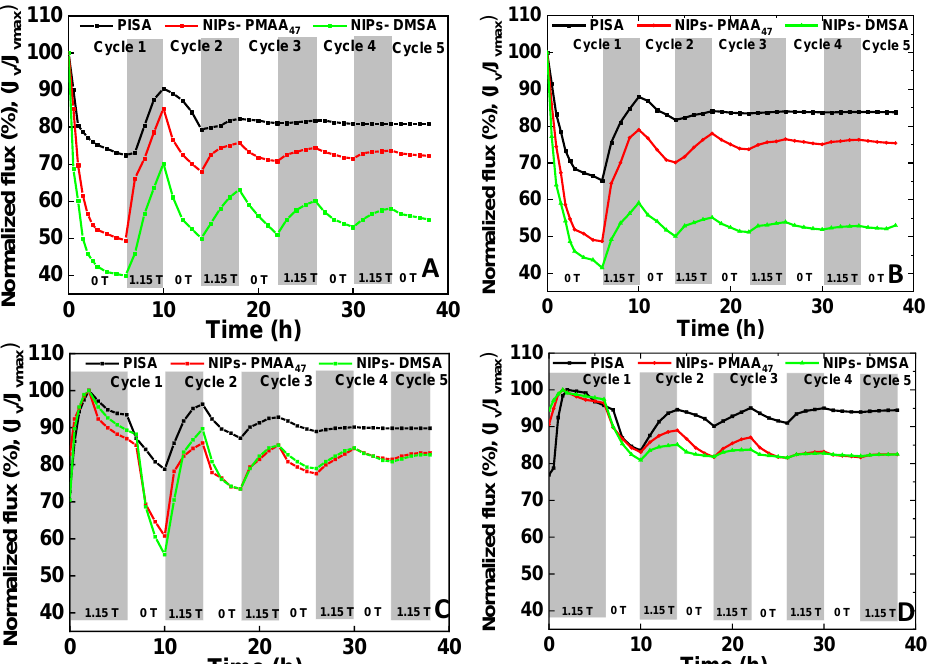
Figure 4. Effect of magnetic field cycles on the permeate fluxes, obtained along with the permeation of a 0.5g/L BSA solution at pH 7.1: ( A ) Strategy 1 (OFF/ON), TMP of 0.5 bar; ( B ) Strategy 1 (OFF/ON), TMP of 3 bar; ( C ) Strategy 2 (ON/OFF), TMP of 0.5 bar; and ( D ) Strategy 2 (ON/OFF), TMP of 3 bar.